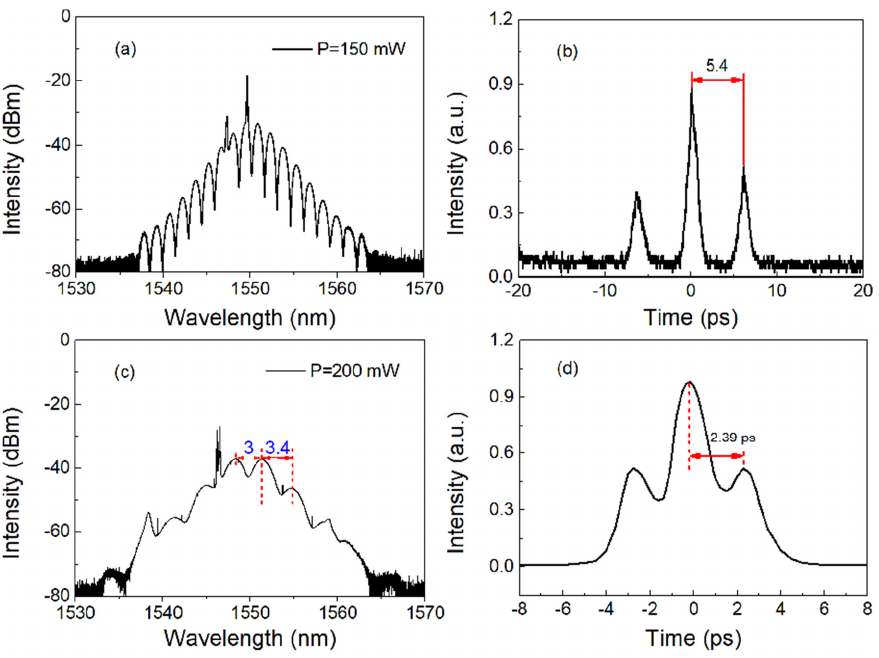
Figure 5. Typical characteristics of two kinds of two-pulse bound solitons: ( a , c ) optical spectra; ( b , d ) autocorrelation traces.